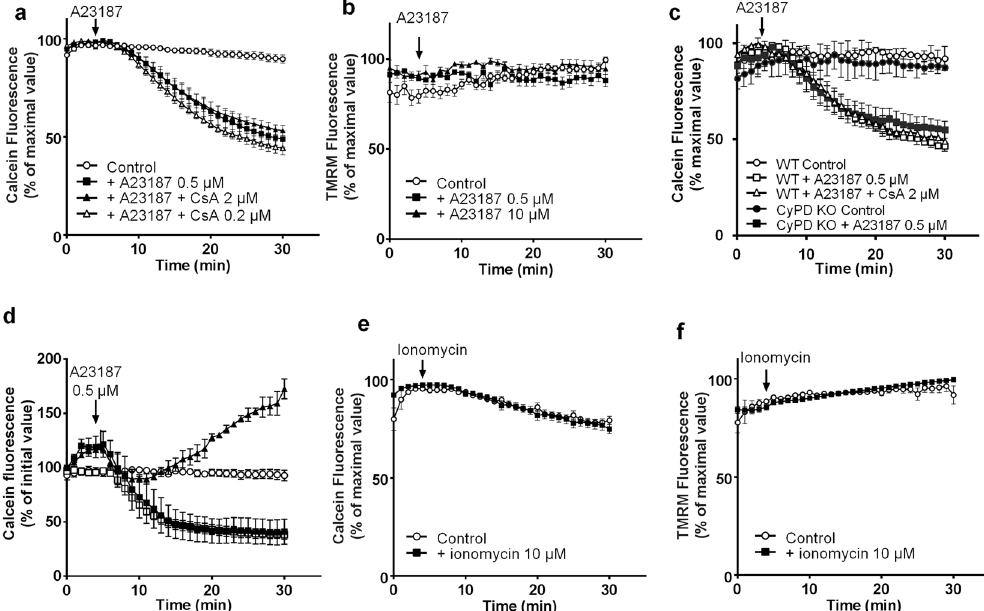
Figure 2. Effect of A23187 and ionomycin on mitochondrial calcein and TMRM fluorescence in isolated cardiomyocytes. Isolated adult cardiomyocytes were co-loaded with calcein, CoCl 2 and TMRM at 37 °C and then incubated in a Tyrode’s buffer. After 5 min incubation A23187 ( a and b ) or ionomycin ( e and f ) were added to the medium. ( c ) Cardiomyocytes isolated from wild type (WT) or CypD knock out (KO) mice were stained with 1 µ M calcein in the presence of 1 mM CoCl 2 , pre-treated with 2 µ M CsA and 0.5 µ M A23187 was added 5 min after recording. ( d ) Cardiomyocytes were incubated in a Tyrode’s buffer without Ca 2 + ( ▪ ), supplemented with 100 µ M EGTA ( ⚪ , ▴ ) or containing 1.3 mM Ca 2 + ( ◽ ). At 5 min, 0.5 µ M A23187 was added (except ⚪ ). Fluorescence values of calcein and TMRM were obtained by averaging pixel intensities after background substraction and were normalised as a percentage of the initial value. Each trace represents the mean ± SEM of 3